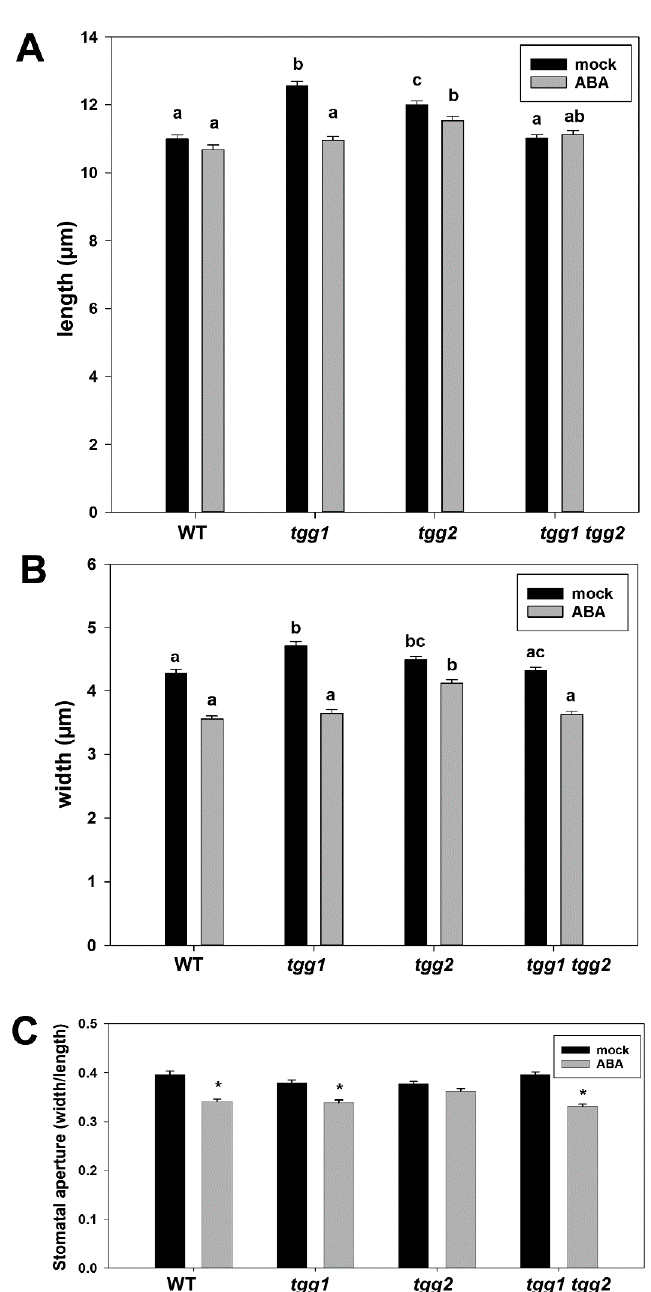
Figure 4. Effect of abscisic acid (ABA) (100 µ M) on stomatal pore length, width, and stomatal aperture of WT and tgg single and double mutants. Length ( A ) and width ( B ) of the stomatal pore in WT, tgg single and double mutants after mock treatment or treatment with ABA. Different letters (a, b and c) above the bars indicate significant differences between WT, tgg1 , tgg2 and tgg1 tgg2 for each treatment as determined by a Kruskal-Wallis test followed by a Tukey test for pairwise comparisons ( p < 0.05). ( C ) Stomatal aperture in WT, tgg single and double mutants after mock treatment or treatment with ABA. Bars represent the means ± SE ( n = 200). Asterisks above bars indicate a significant effect of the ABA treatment on stomatal aperture (* p <